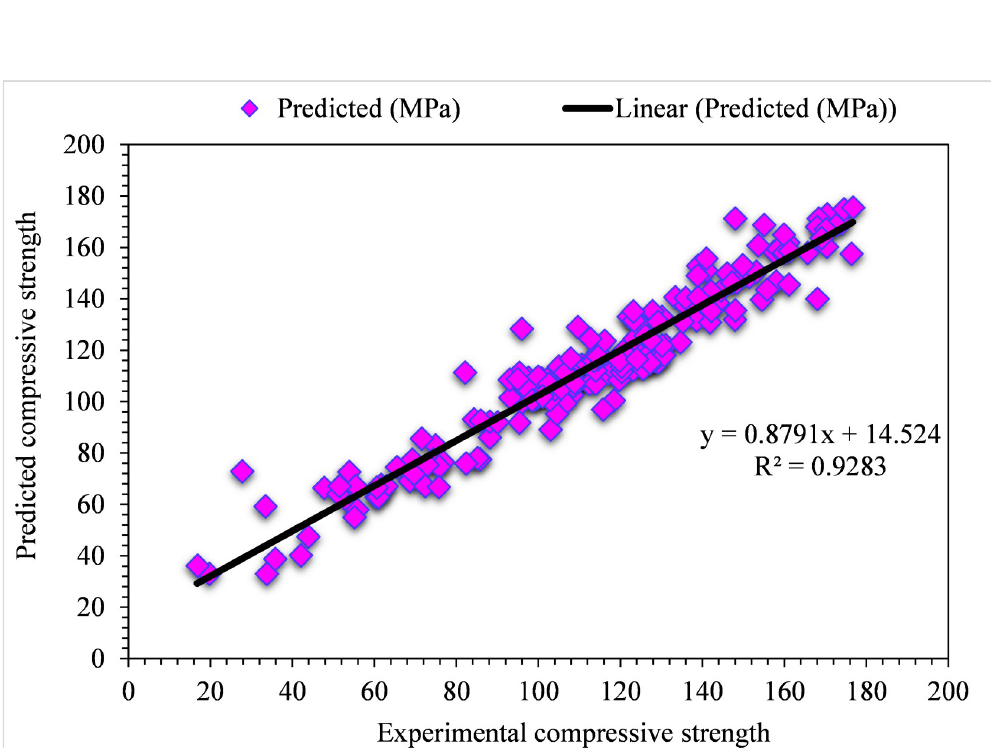
Fig 14. BA predicted and experimental values—UHPC compressive strength.